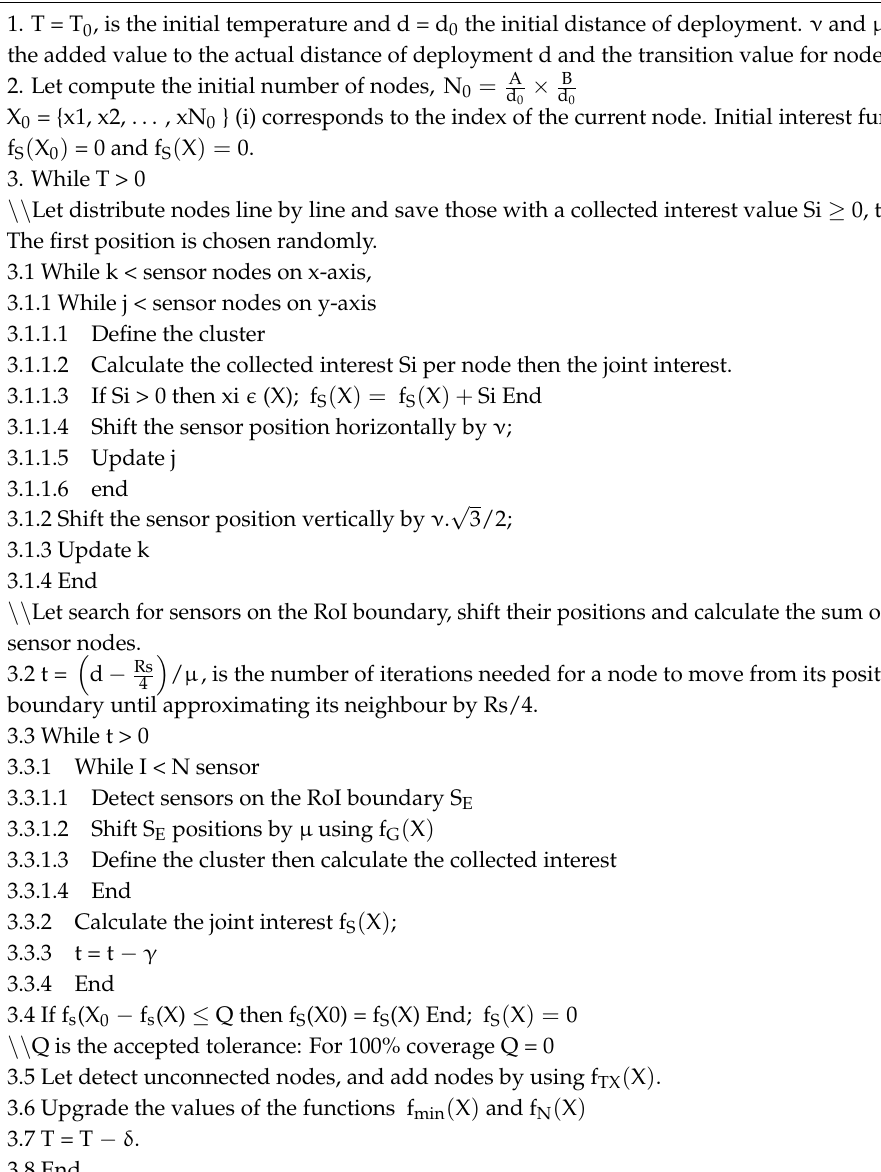
Algorithm 1: Gradient—SA Hybrid Algorithm for Sensor